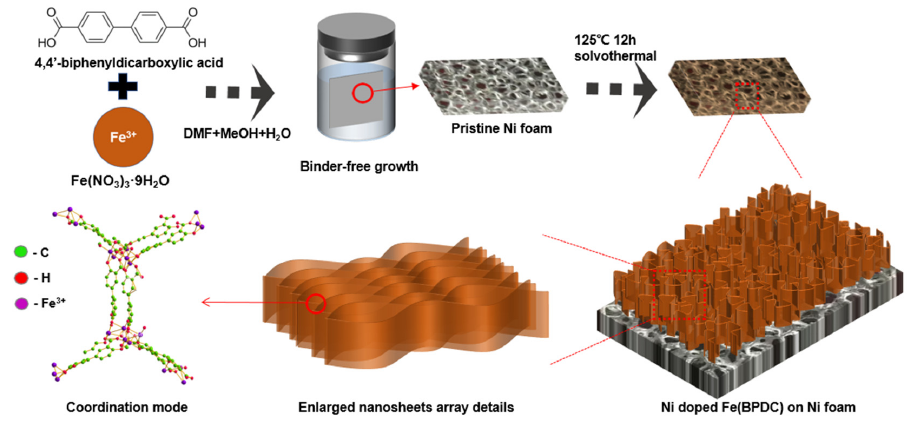
Figure 1. Working procedure and coordination environment of Fe 3+ in Fe(BPDC).